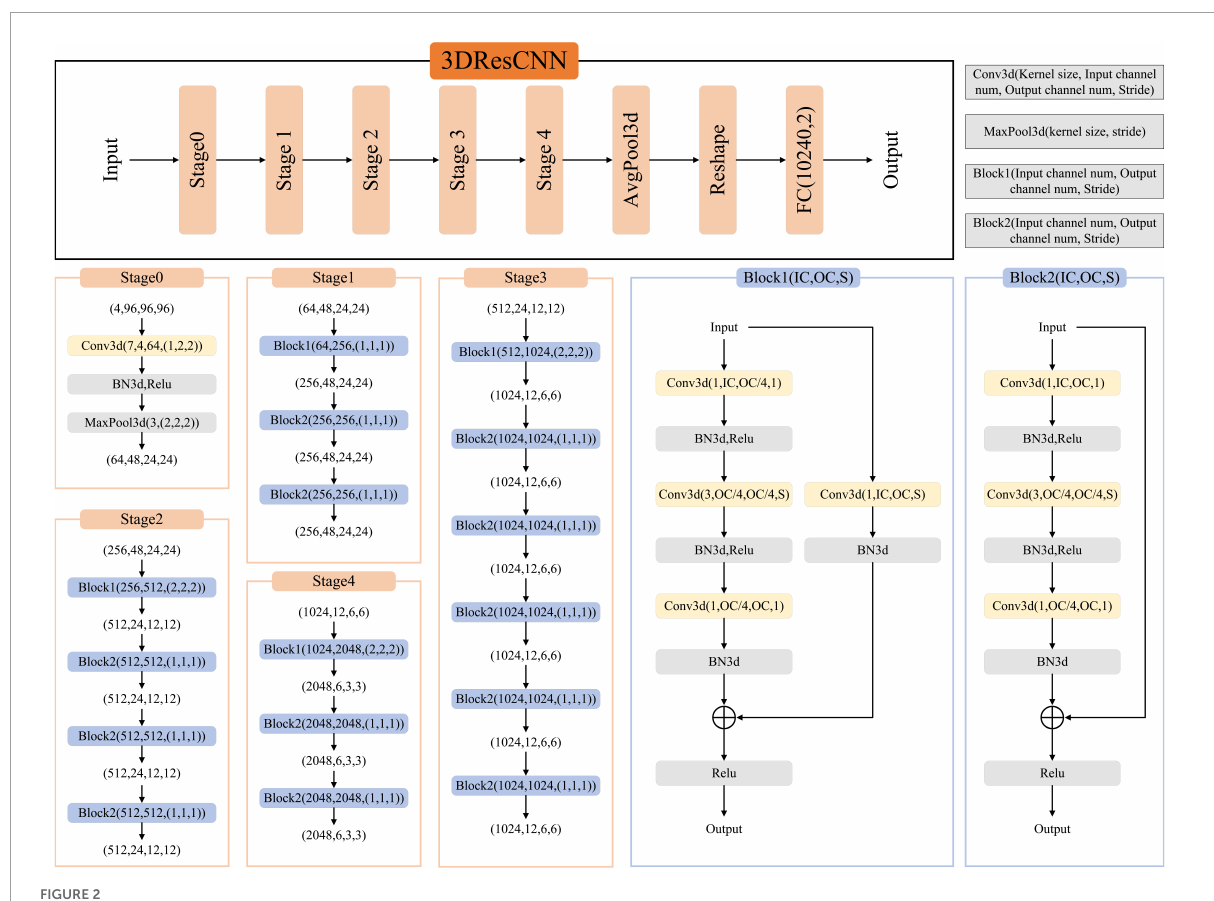
FIGURE2 The network framework for FRGs signature prediction.